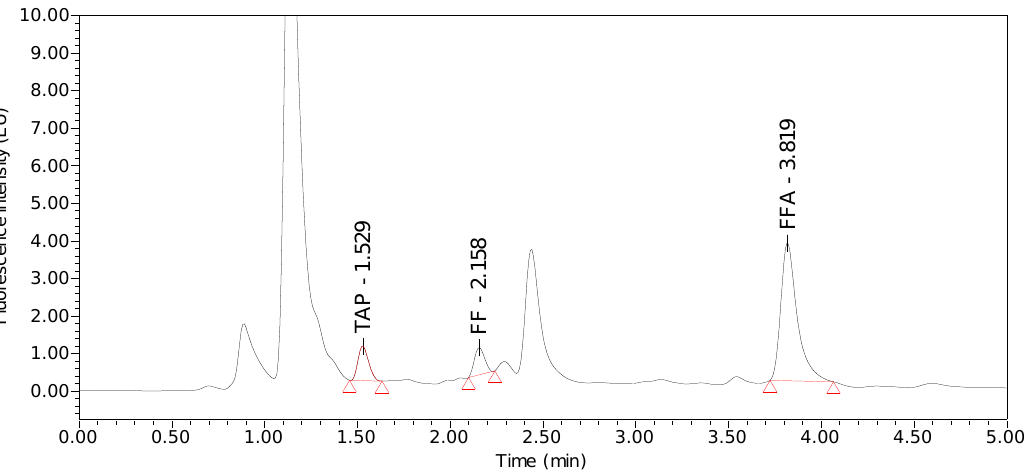
Figure 6. Chromatogram of the blank hen egg spiked with 25 µg/kg TAP and 50 µg/kg FF and FFA standards.